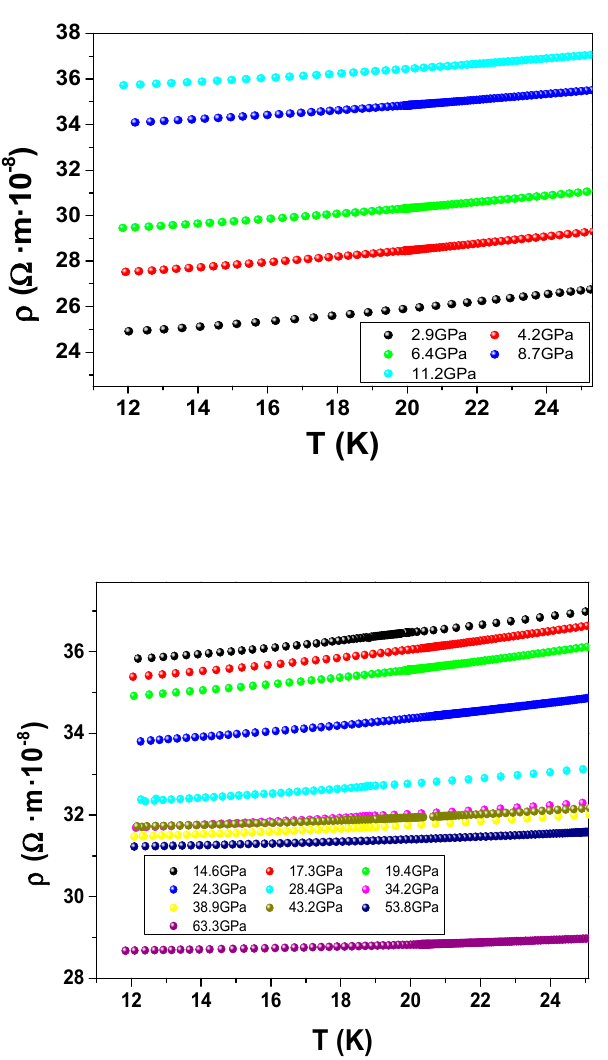
Figure 6. The resistivity under a normal state as a function of pressure.